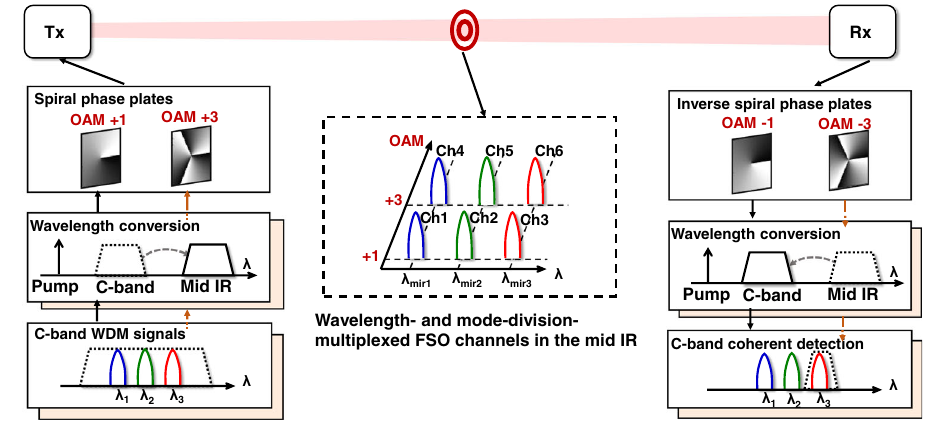
Fig. 1 | Concept for the mid-infrared (IR) wavelength-division-multiplexing (WDM) and orbital angular momentum (OAM)-based mode-division- multiplexing (MDM) free-space optical (FSO) communication system. Mid-IR WDM signals are generated by wavelength converting C-band signals using the